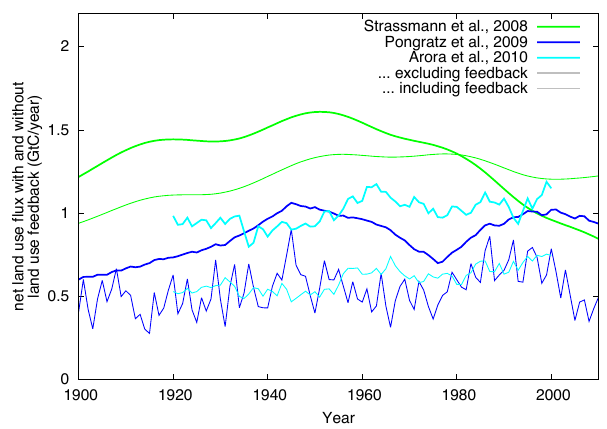
Fig. 3. Net LULCC fluxes including (thin lines) and excluding (thick lines) the land use feedback from Strassmann et al. (2008), Pongratz et al. (2009b), and Arora and Boer (2010) 1 . The land use feedback is of the order of 25% for Strassmann et al. (2008) and of 50% for Pongratz et al. (2009b) and Arora and Boer (2010) of the net LULCC flux excluding the land use feedback. 1 The following methods were used in the individual studies: for the flux excluding the land use feedback: D1 (uncoupled DGVM simulations under undisturbed environmental conditions) by Strassmann et al. (2008) and Pongratz et al. (2009b), and D3 (uncoupled DGVM simulations under transiently changing environmental conditions influenced by both LULCC and fossil-fuel burning) by Arora and Boer (2010). For the LULCC flux including the land use feedback: E1 (ESM simulations not accounting for fossil-fuel burning) by Pongratz et al. (2009b), and E2 (ESM simulations accounting for fossil-fuel burning) by Strassmann et al. (2008) and Arora and Boer (2010). Difference of the methods (as can be derived from Results section or Fig. 2) yields the exact flux